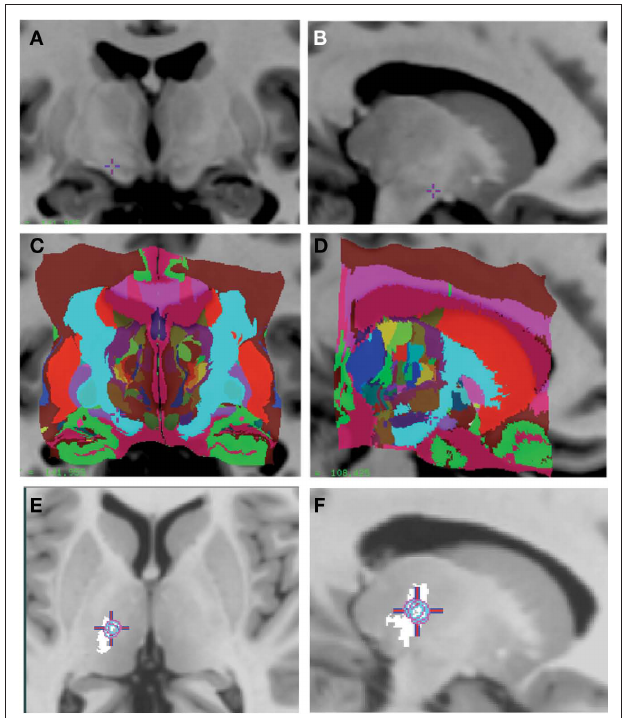
Figure 3 | (A–D) Voxel-label atlas of the basal ganglia and thalamus integrated into a high-contrast high-resolution MRI (Colin27). (e,F) The sensory thalamus is isolated in the atlas and represented on coronal and sagittal views. The average stereotactic position of the somatosensory responses obtained during stereotactic neurosurgery in the thalamus from nine patients is integrated into the same MRI. The somatosensory responses were obtained using a curved retractable stimulator, and the position of hand/arm area responses from multiple patients was analyzed in the atlas-integrated reference space. The circle represents the 90% probability map of somatosensory responses, which map to the rostral portion of the ventral posterior somatosensory nucleus of the thalamus.